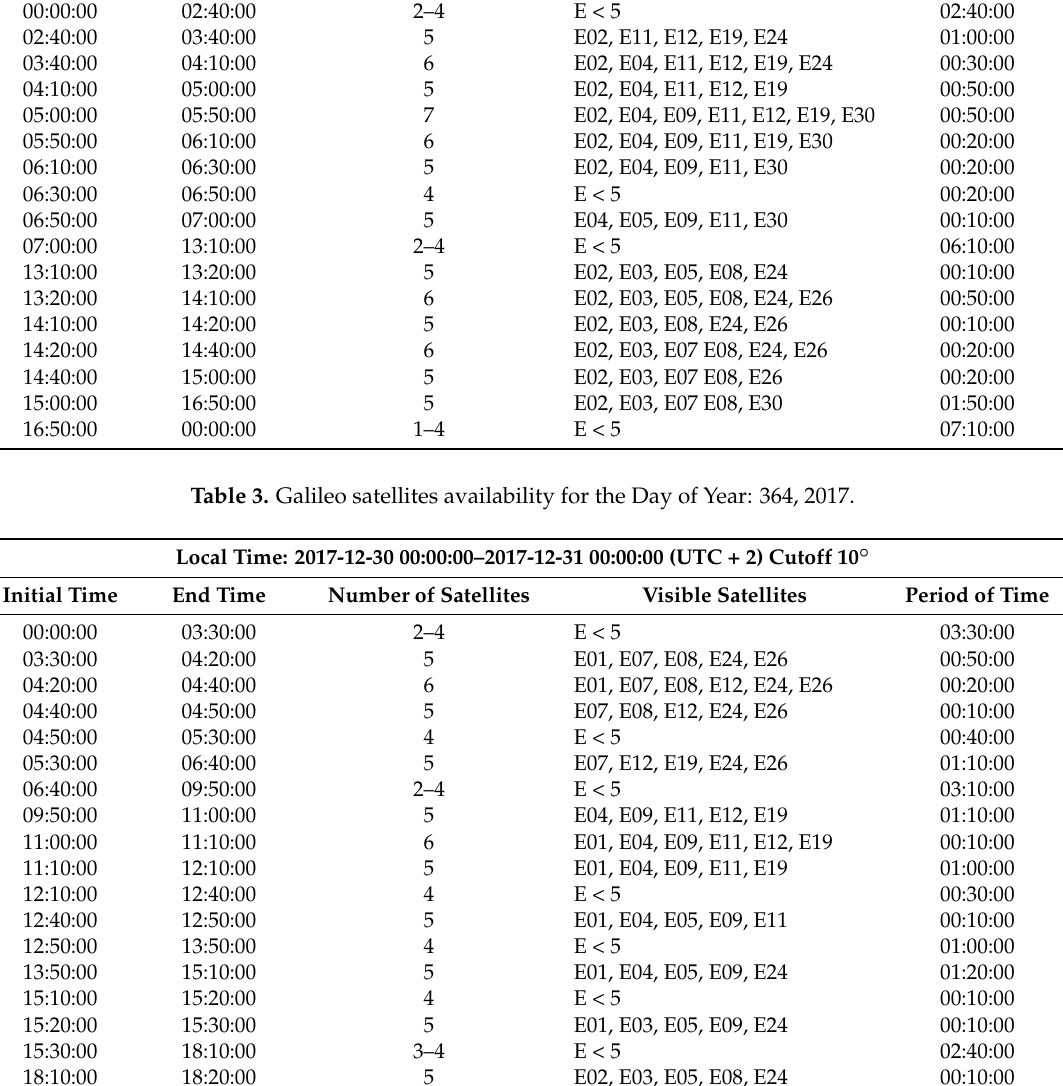
Visible Satellites